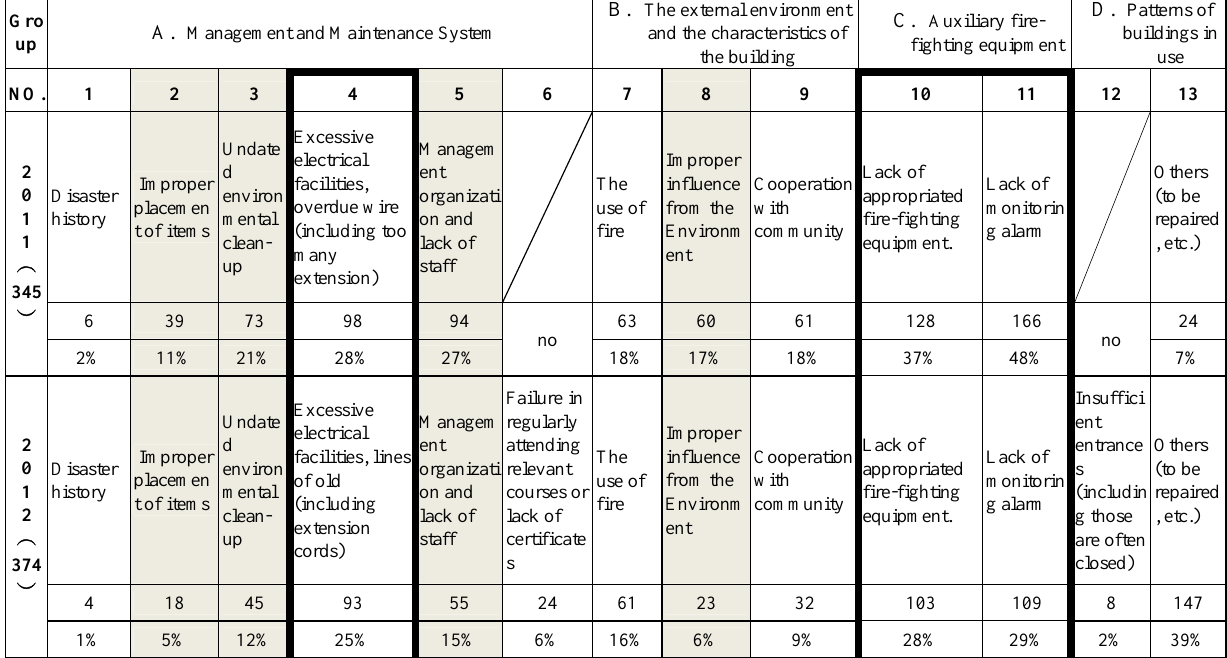
Table 2. 2011-12 Hazard indicators statistical chart Gro up